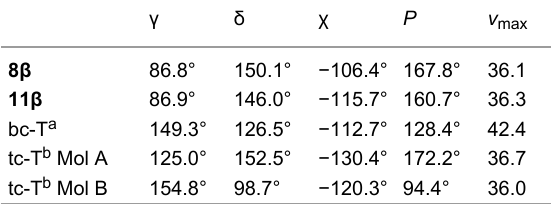
Table 1: Selected backbone torsion angles and sugar pucker data for 8 β and 11 β and related bi/tricyclo-nucleosides from X-ray structures. γ δ χ P ν max 8